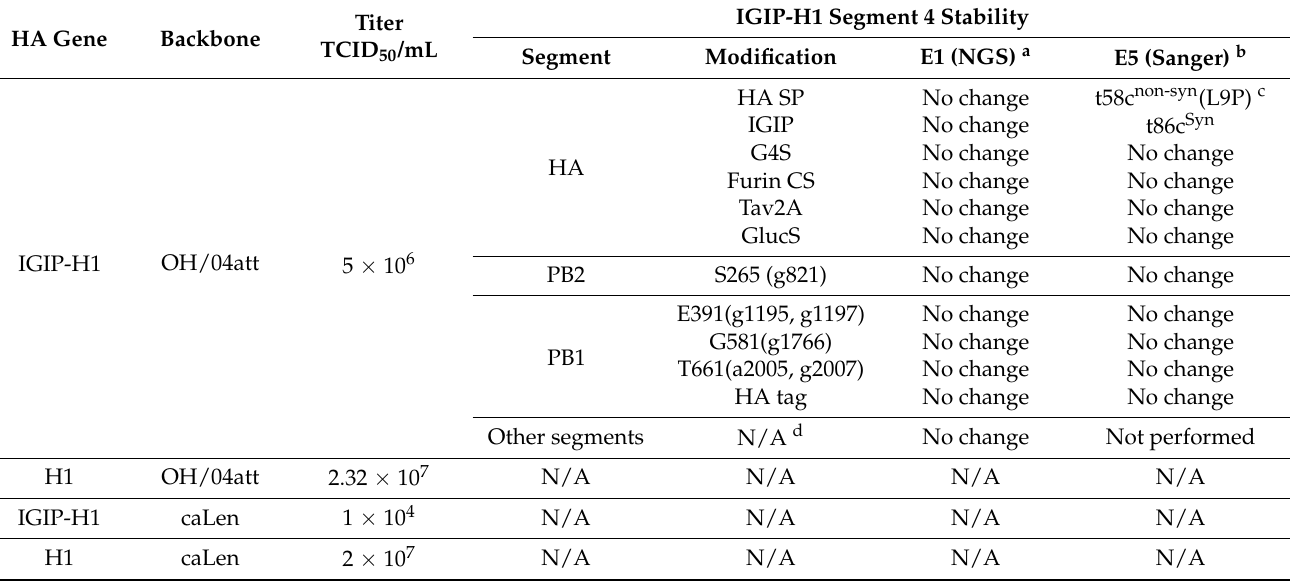
Table 1. Viral titers of the different viruses evaluated in this